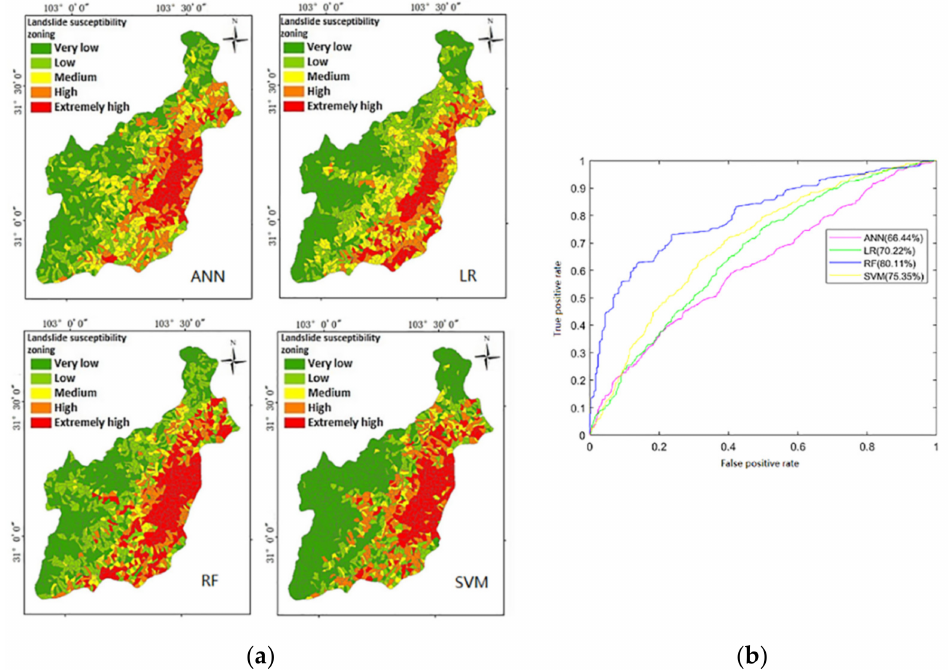
Figure 9. Wenchuan earthquake-induced landslide susceptibility assessment and ROC: ( a ) landslide susceptibility assessment (ANN, LR, RF, and SVM); ( b )